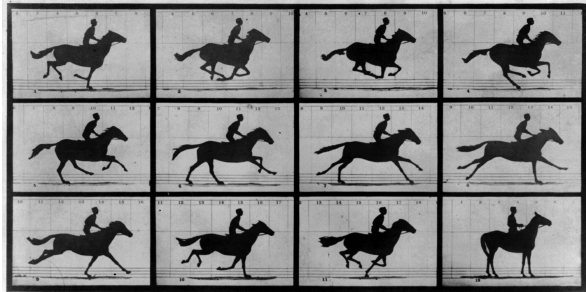
Fig. 1. Motion-picture photography of a galloping horse performed by Eadweard Muybridge in 1878 (Image courtesy of Eadweard Muy- bridge). He used an array of cameras to obtain a sequence of shots to determine whether the horse’s feet were all off the ground at